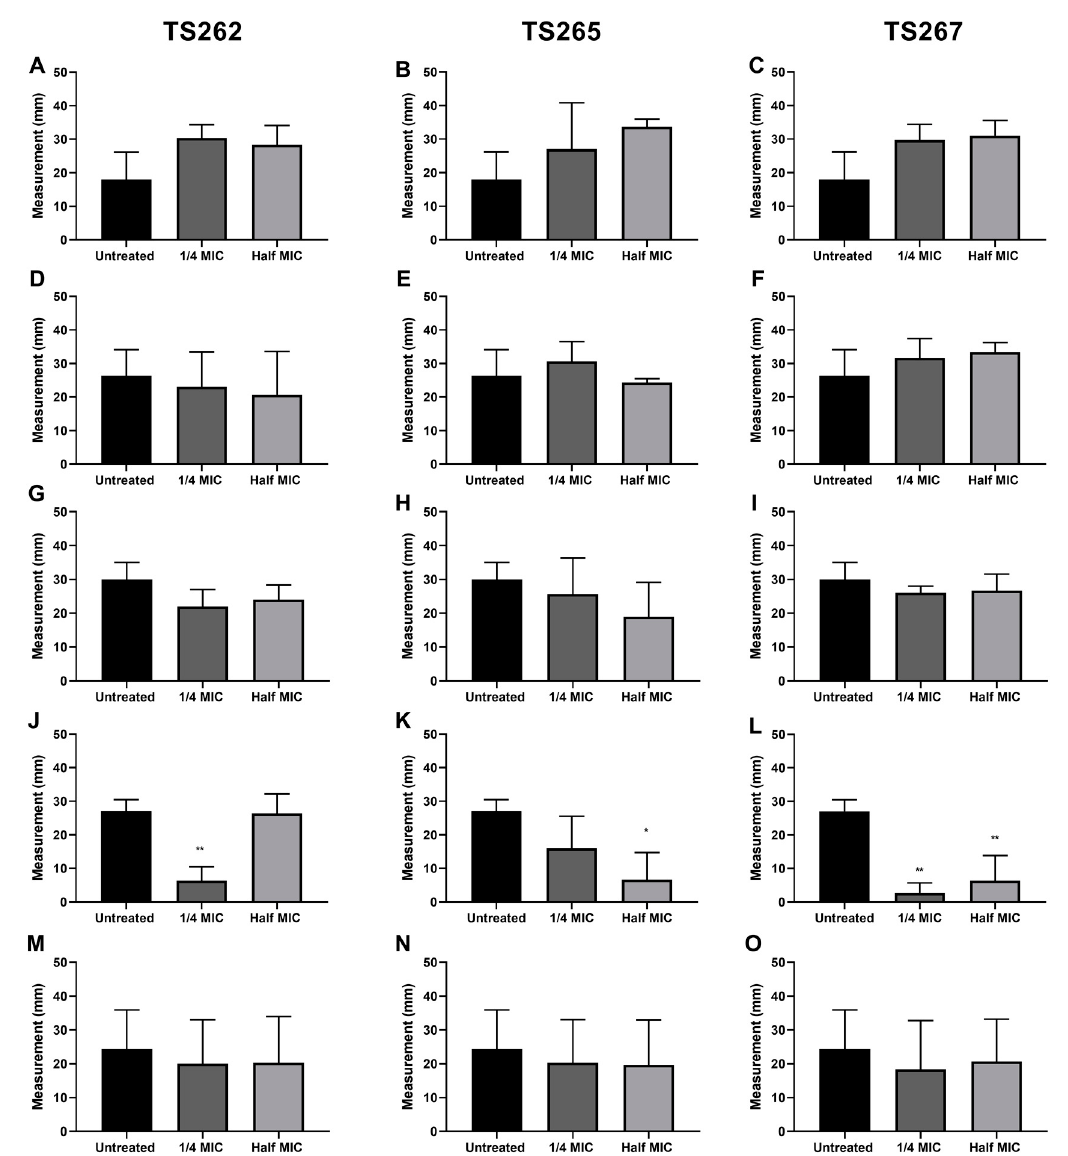
Figure 3. Effect of the anti-tumour compounds on bacterial swimming. The motility of L. monocytogenes ( A – C ), E. coli ( D – F ), S. Typhimurium ( G – I ), A. baumannii ( J – L ), and P. aeruginosa ( M – O ) was assessed in 0.4% MH agar. The results presented correspond to the average of three independent experiments ± standard deviation (SD). * p < 0.005 was considered significant and highly significant when ** p < 0.01 (one-way ANOVA test).